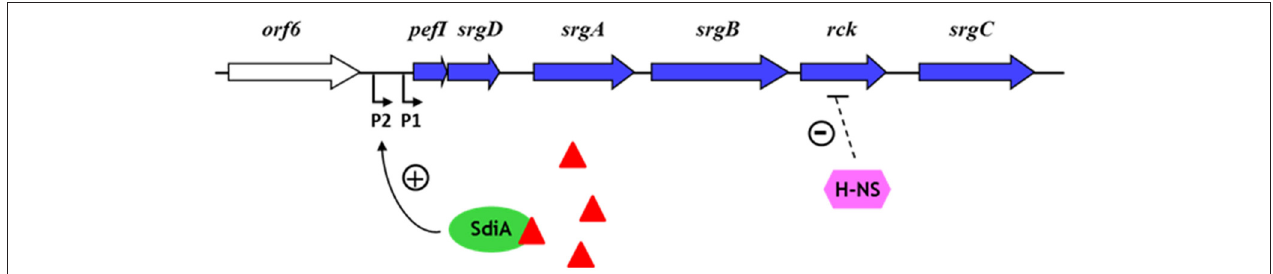
FIGURE 2 | Regulation of rck expression in S. Typhimurium. The six ORFs belonging to the pefI-srgC operon are represented by blue arrows. The two promoters identified upstream of pefI are indicated by broken arrows (Abed et al., 2014). Red triangles represent acyl-homoserine lactones (AHLs). The dashed line for negative H-NS regulation means that the target of H-NS is